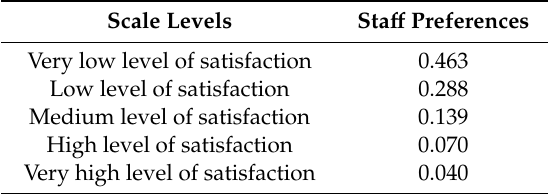
Table 14. Weightings of the scale levels of the descriptor of Sta ff preferences.